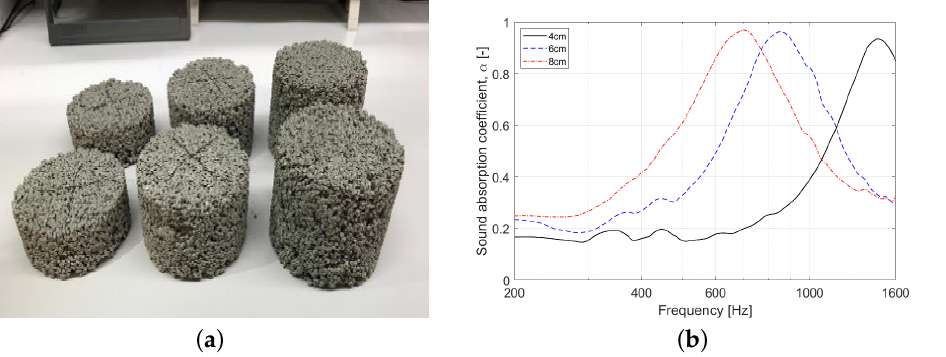
Figure 7. Sound absorption behaviour of porous concrete. ( a ) Porous concrete built samples. ( b ) Average of the sound absorption coefficient for three different thicknesses: 4, 6, and 8 cm. (retrieved from